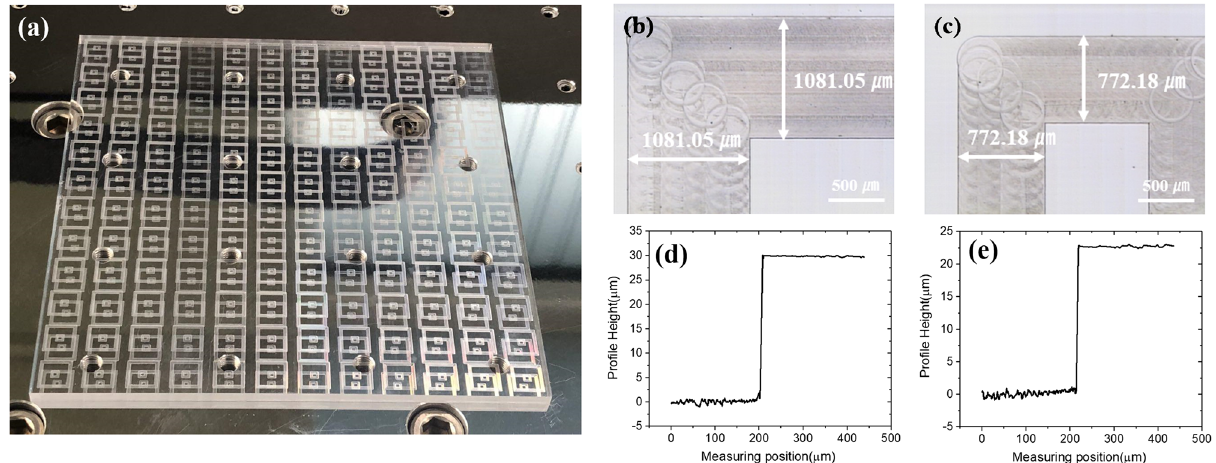
Figure 9. Measuring results of engraved double square loop on the PMMA workpiece by the micro-end- milling. ( a ) A camera image of machined PMMA workpiece after the end-milling process, ( b ) top view of the outer pattern, ( c ) top view of the inner pattern, ( d ) depth profile of the outer pattern, and ( e ) depth profile of the inner pattern.